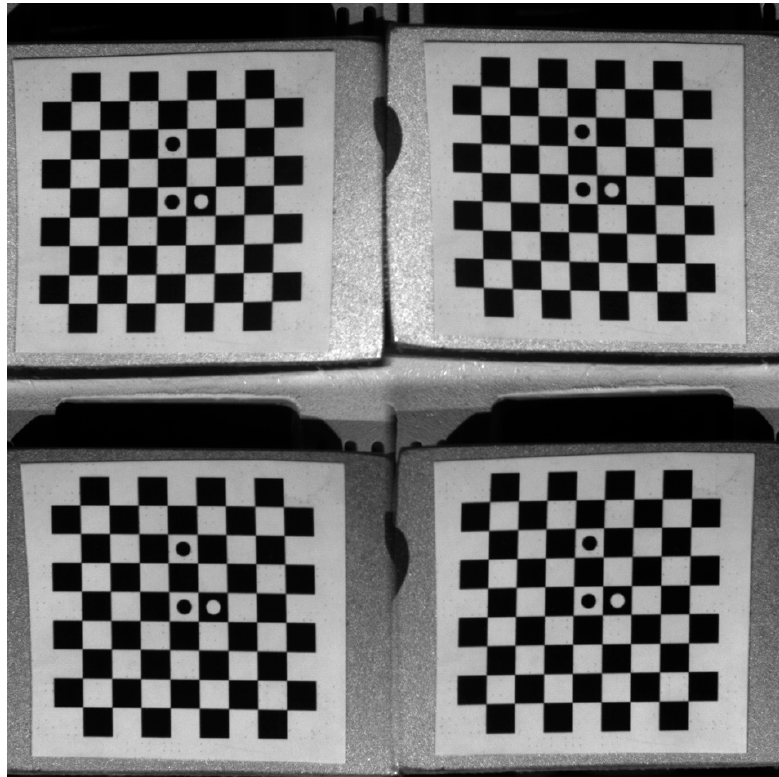
Figure 4. Calibration image of a chessboard calibrator from four views.